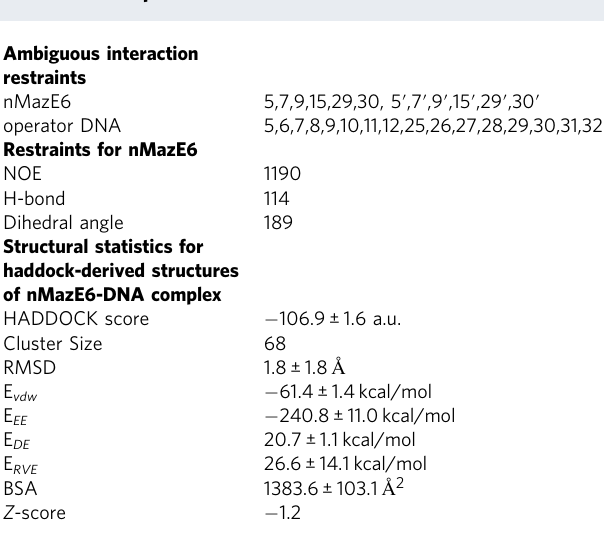
Table 3 Structural statistics for data-driven docking of nMazE6 and operator